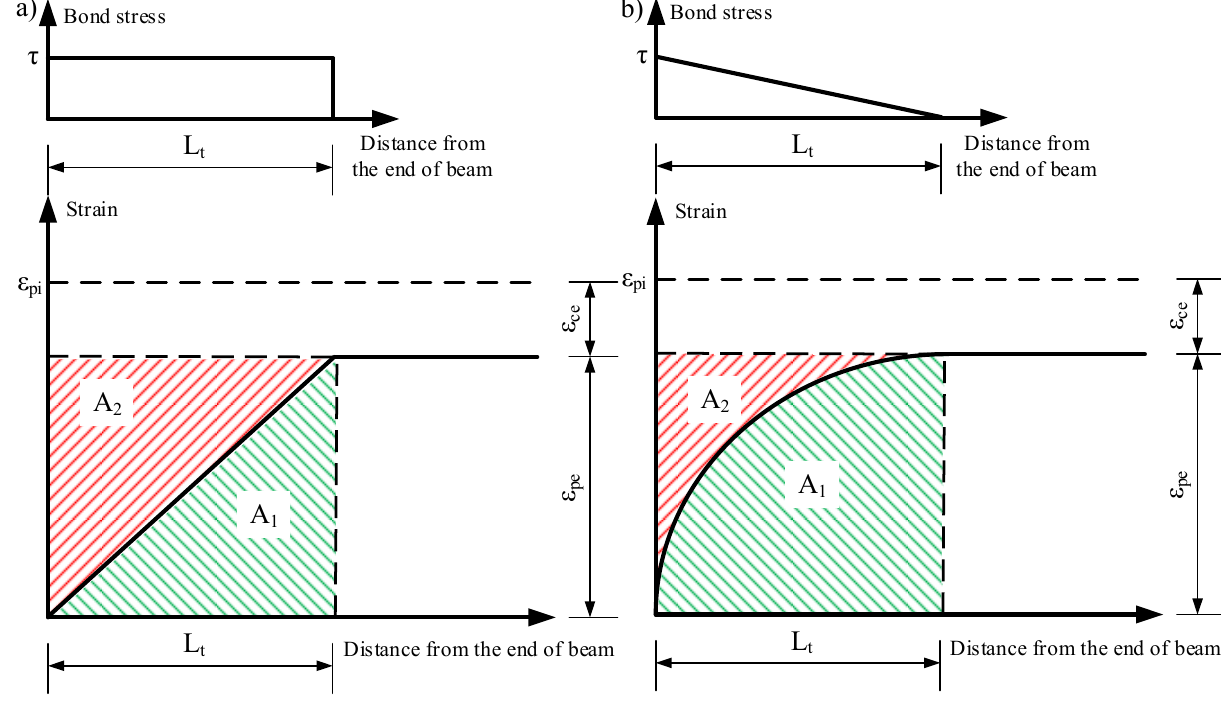
Figure 2. Strain variation over transfer length ( a ) linear and ( b ) parabolic, and corresponding bond stress distribution.